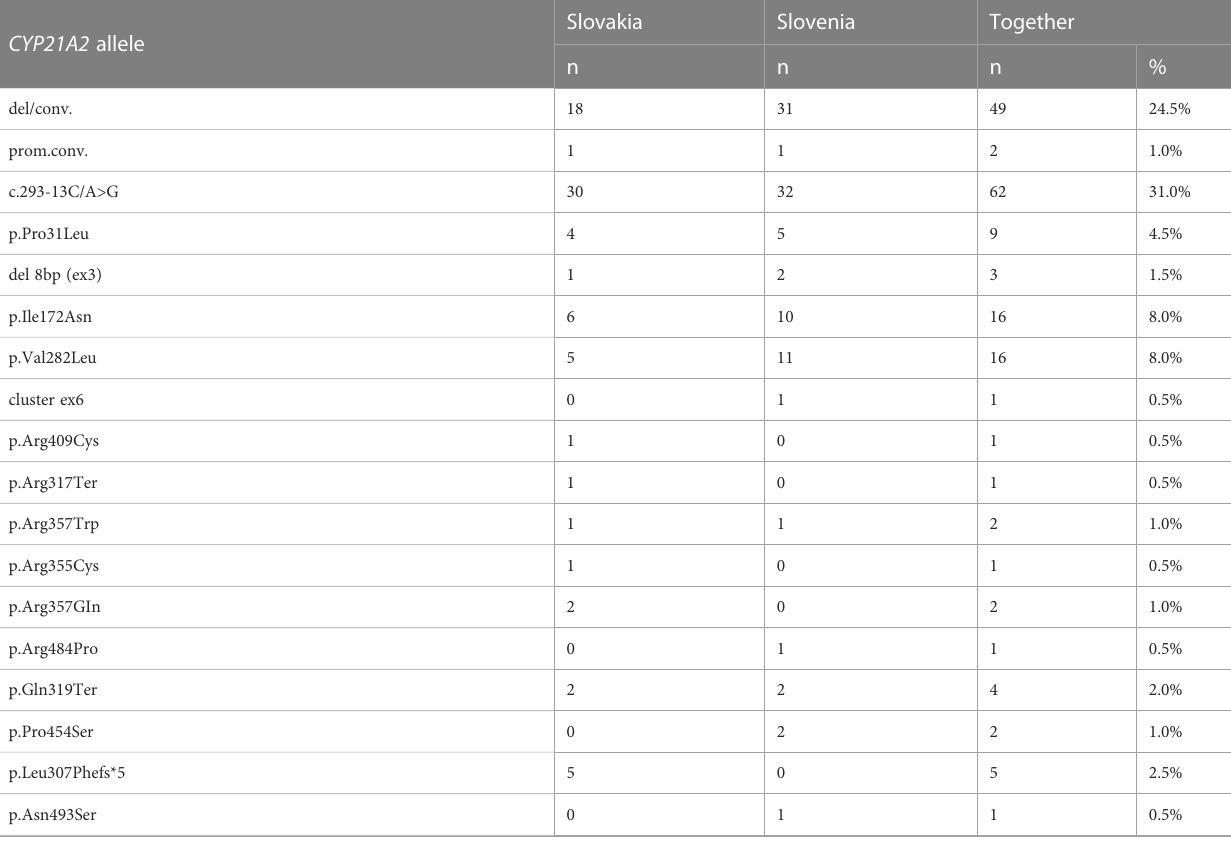
TABLE 2 CYP21A2 allele frequencies in individual populations of the cohort. CYP21A2 allele